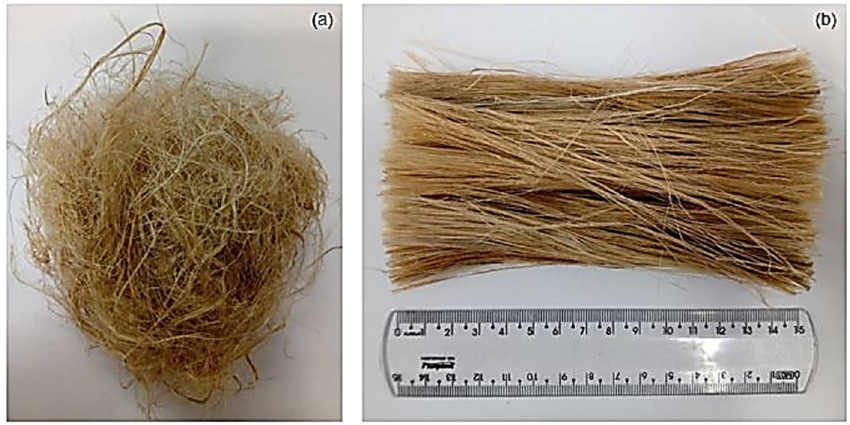
Figure 2. Kenaf fibers (a) as received; (b) after cleaning and separating the